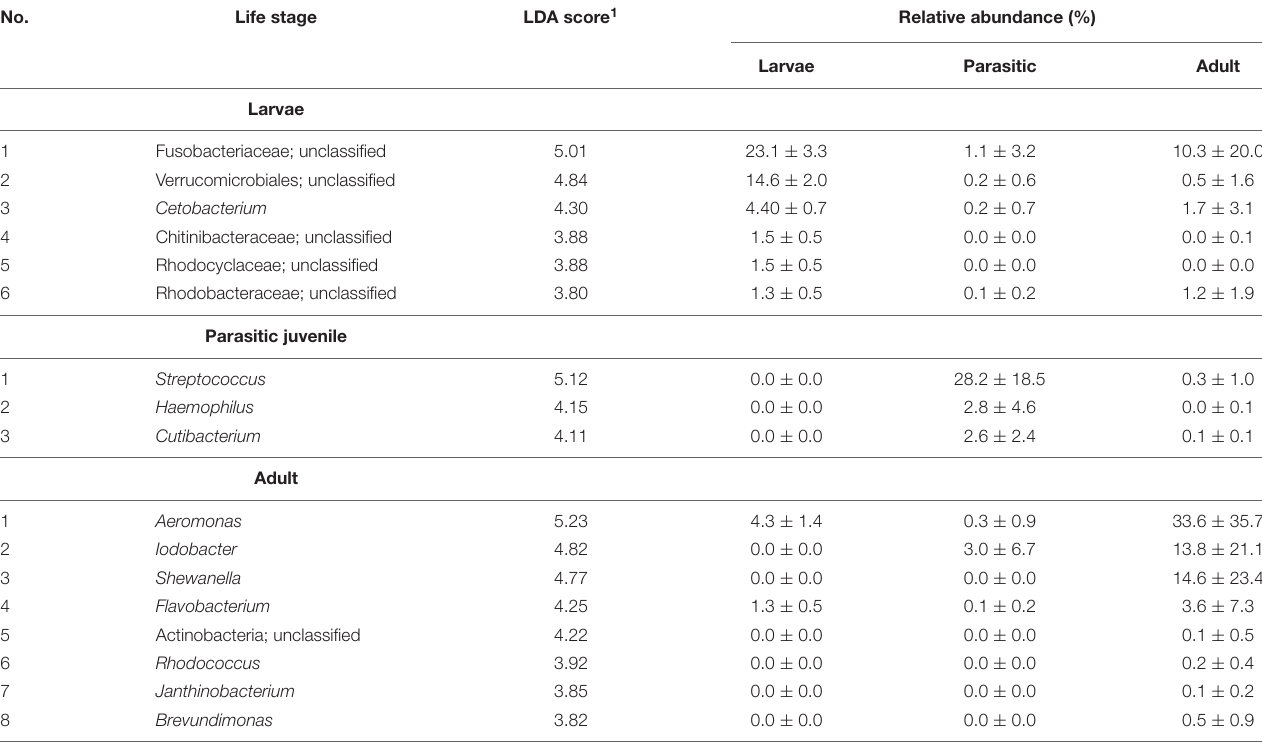
TABLE 1 | Taxa enriched in different life stages of sea lamprey ( Petromyzon marinus ) as determined by LEfSe analysis.